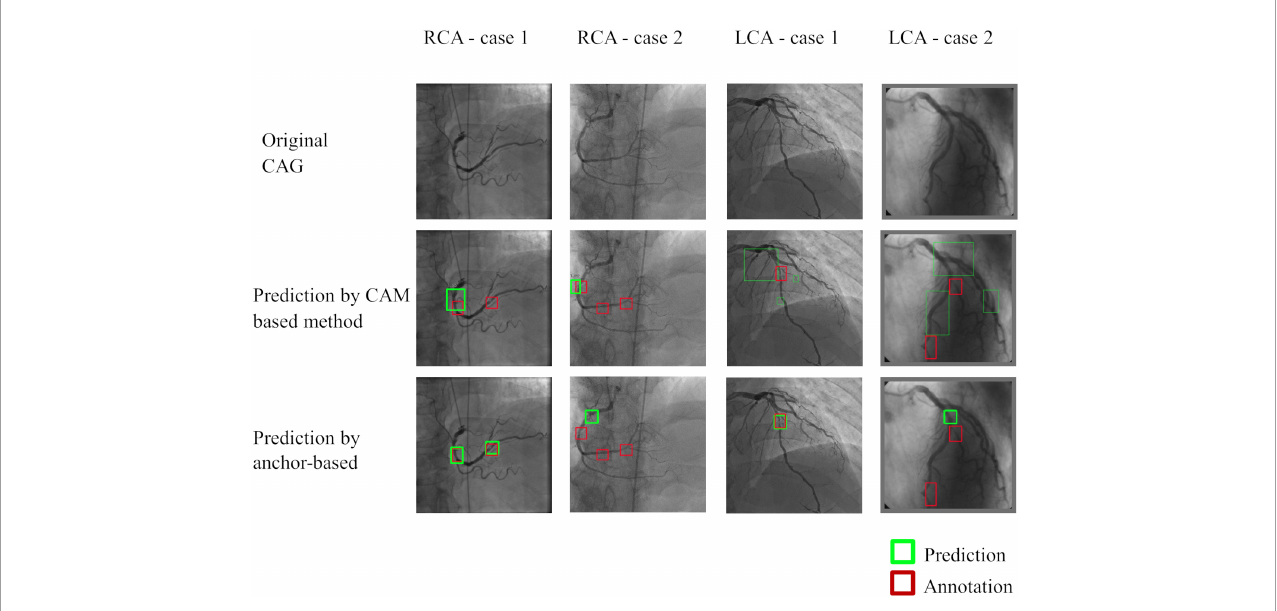
FIGURE5 Representative images of stenosis position localization experiments. Predicted boxes from the anchor-based model produced more accurate boxes when compared to the CAM-based model. Multiple stenoses in distal coronary arteries or branches were difficult for correct localization, which was the main reason for the failed